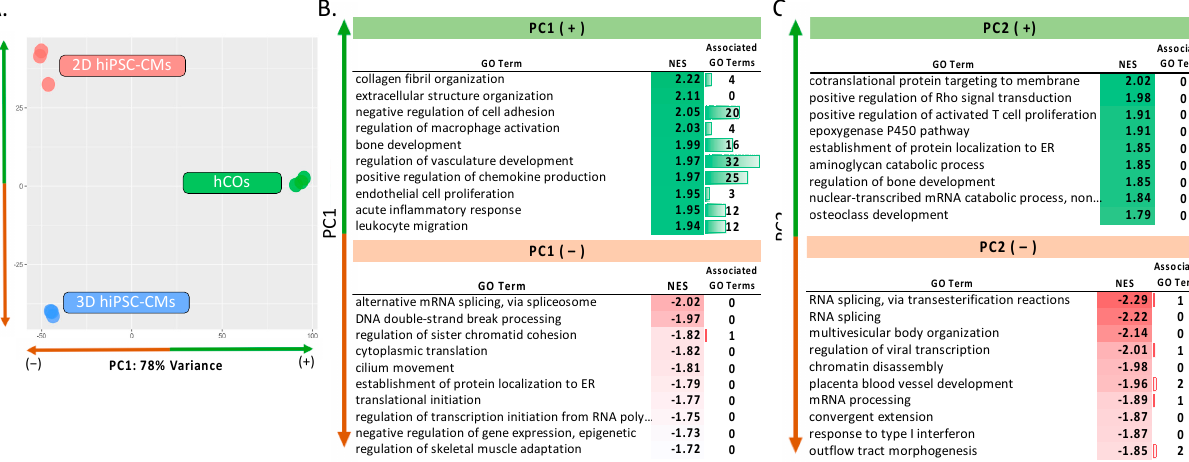
Figure 2. PCA and GSEA analysis of in vitro cardiac models. GSEA analysis performed using gene loadings from PC1 and PC2. Associated GO terms depict redundant GO terms filtered out through REViGO. ( A ) PCA of 2D hiPSC-CMs, 3D hiPSC-CMs and hCOs. ( B ) 10 significantly enriched GO terms along PC1(+)(top) and PC1(–)(bottom): PC1(+) depicted pathways enriched in hCOs; PC1(–) depicts pathways co-enriched in 2D hiPSC-CMs and 3D hiPSC-CMs. ( C ) 10 significantly enriched GO terms along PC2(+)(top) and PC2(–)(bottom): PC2(+) represents pathways enriched in 2D hiPSC-CMs; PC2(–) represents pathways enriched in 3D